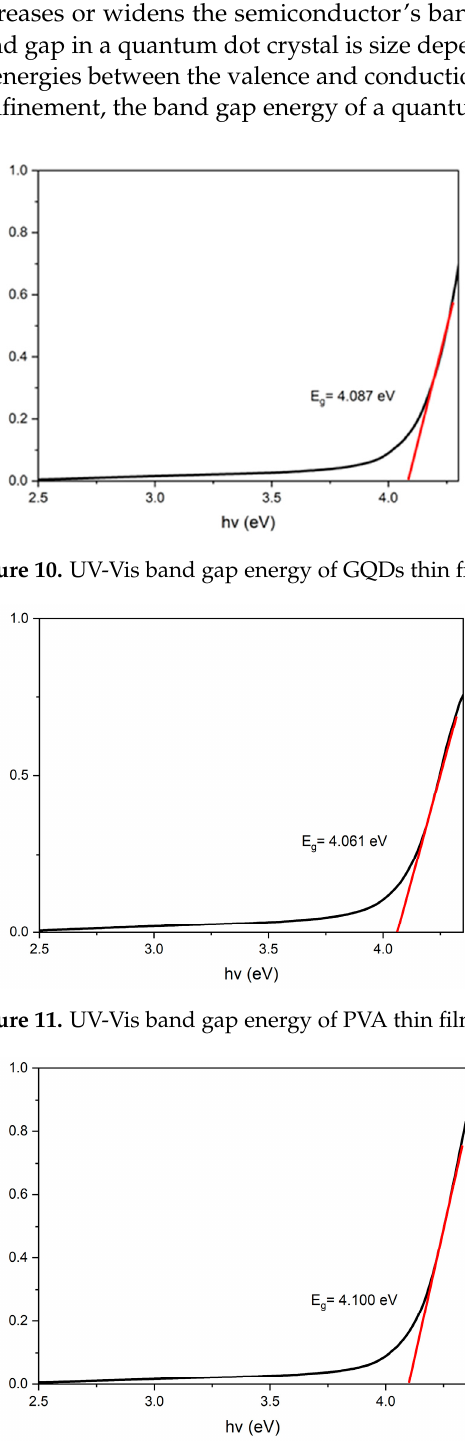
Figure 12. UV-Vis band gap energy of GQDs − PVA thin film.